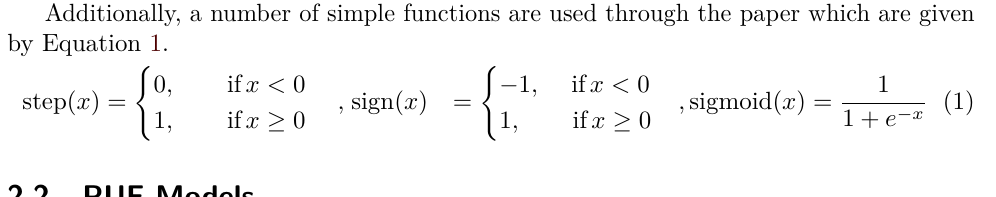
Figure 1: Overview of Interpose PUF, XOR APUF, and APUF